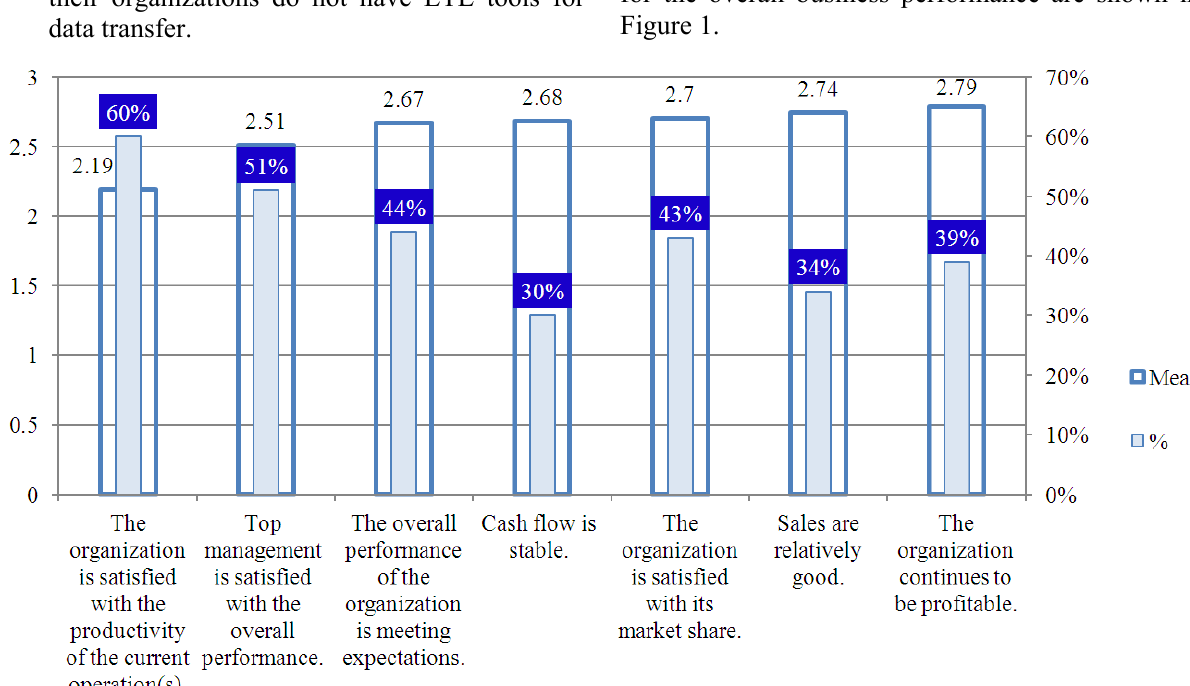
Strongly Slightly Slightly Strongly Std. Mean deviation disagree disagree agree agree